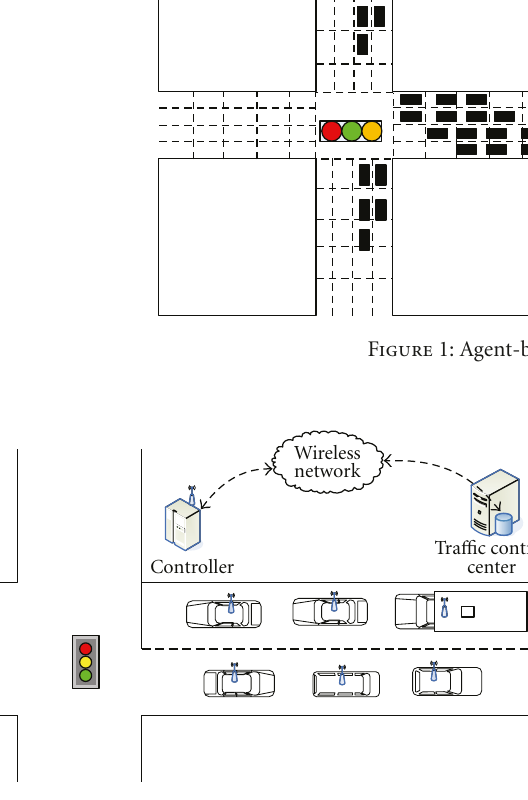
Figure 2: Illustration of tra ffi c information exchange